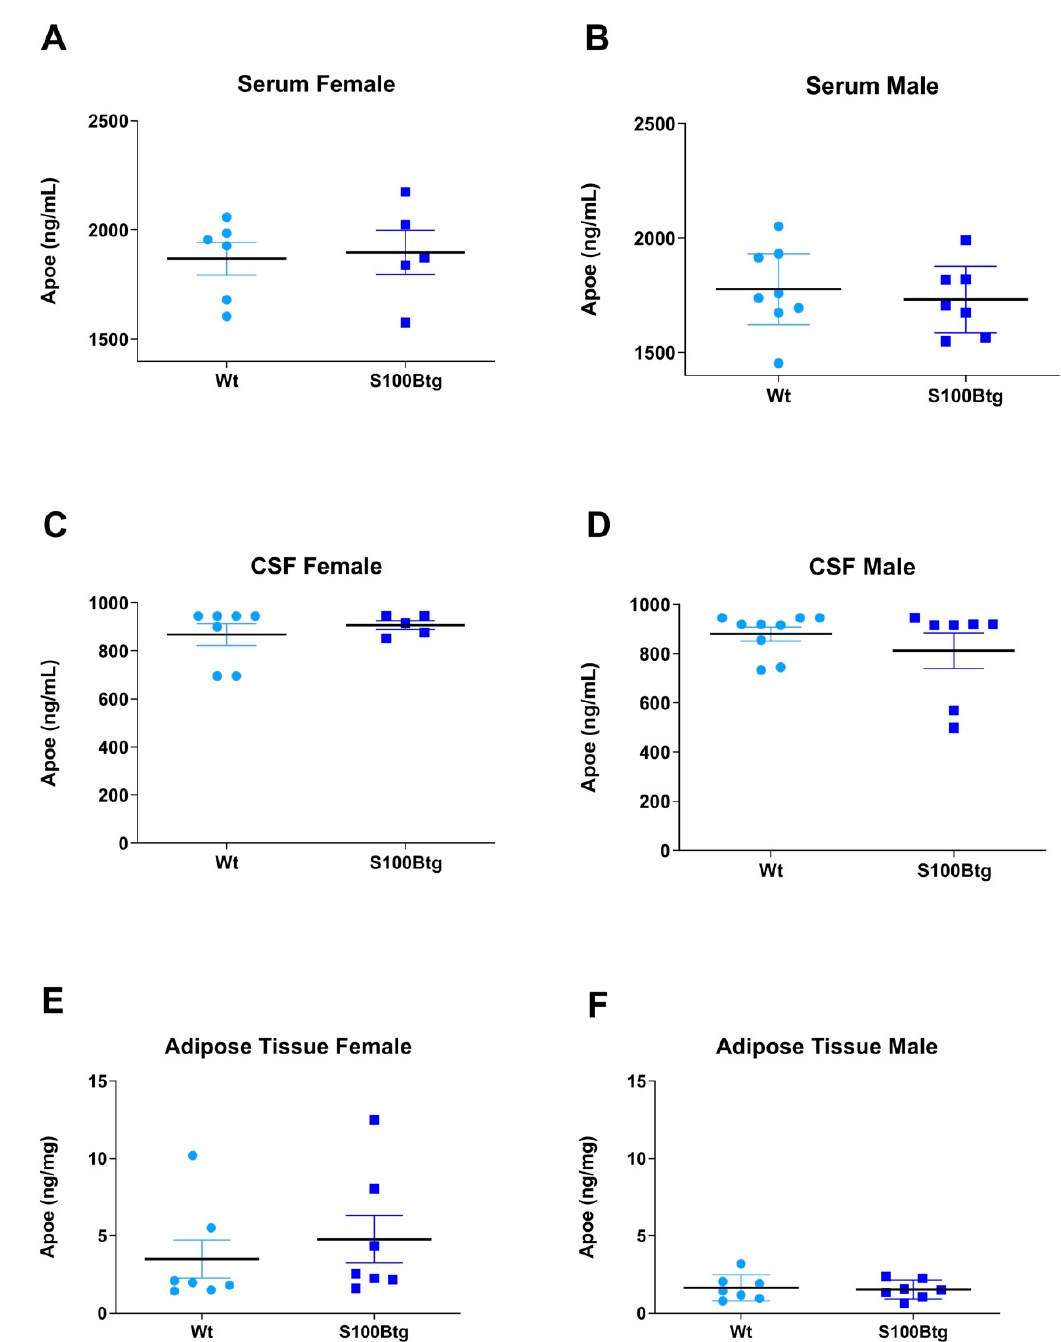
Figure 3. ApoE level in blood serum, cerebrospinal fluid, and adipose tissue in one-year-old S100Btg and wt mice. ( A , B ) serum, ( C , D ) cerebrospinal fluid, and ( E , F ) adipose tissue; measurements were performed by ELISA. Data are expressed as means ± SE (7 mice/group).